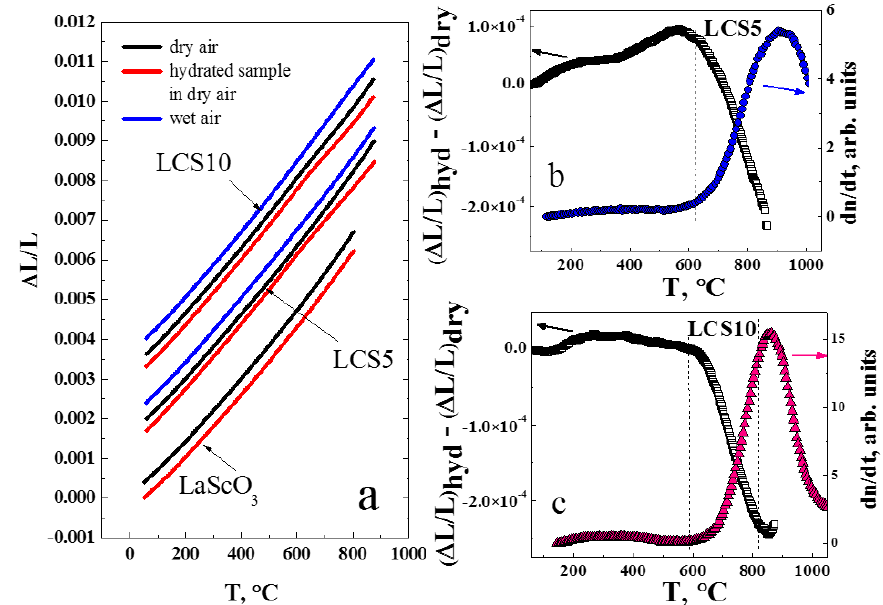
Figure 5. Thermal expansion measurements of LCS and LaScO 3 [24] ceramic samples: ( a ) Initial dilatometric curves in dry ( p H 2 O < 0.1 kPa) and wet ( p H 2 O = 3.2 kPa) air; ( b ) the di ff erence between expansion of hydrated and dried LCS5 (left axe) and TDS of water (right axe); ( c ) the di ff erence between expansion of hydrated and dried LCS10 (left axe) and TDS of water (right axe).